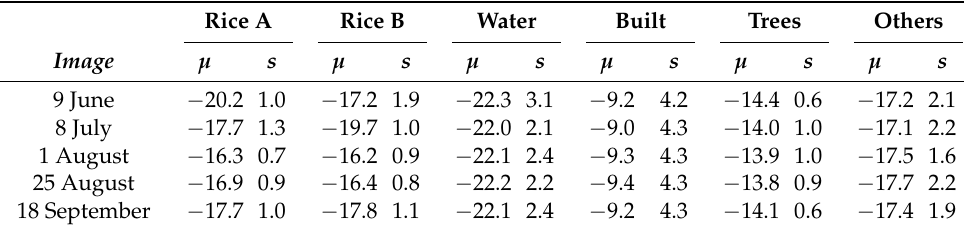
Table 2. Temporal backscatter coefficients for all land-cover classes at VH